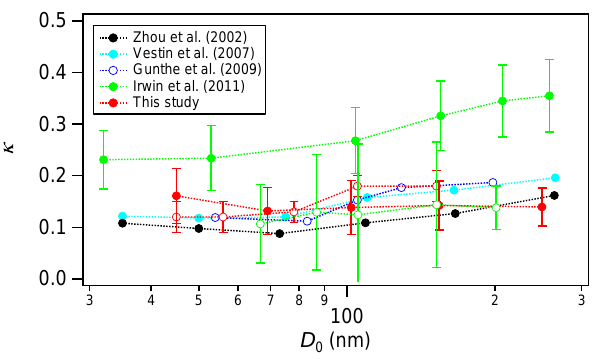
Figure 14. Comparing κ as a function of diameter for this and previous studies in Amazonia and Borneo. Filled circles represent HTDMA-derived values, while empty circles are CCNc-derived values. Error bars represent ± 1 standard deviation, where these data are available. The values for Zhou et al. (2002) and Vestin et al. (2007) were calculated by Gunthe et al.